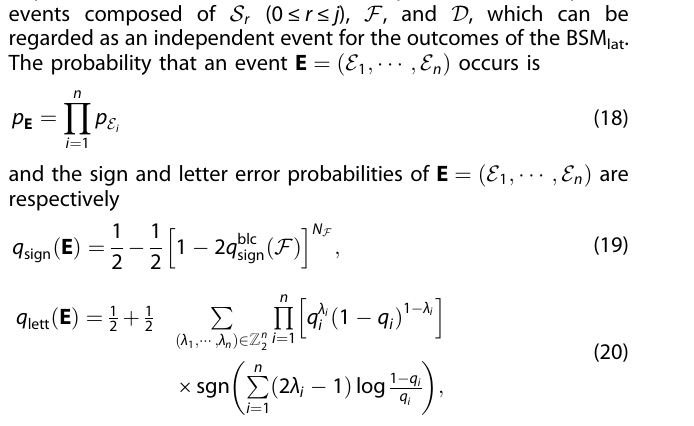
Fig. 9 Decomposition of a graph state. A graph state is decomposed by separating recurrent subgraphs that are connected with multiple